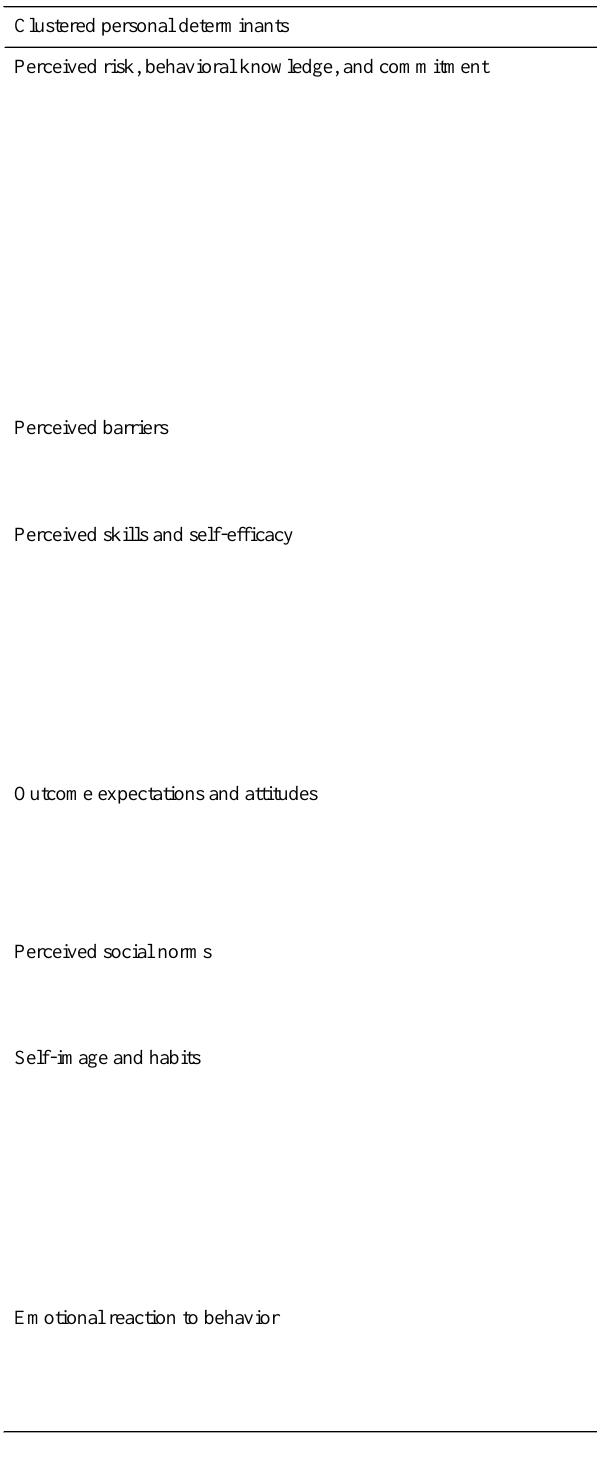
Table 2. Behavior change methods to address clustered personal